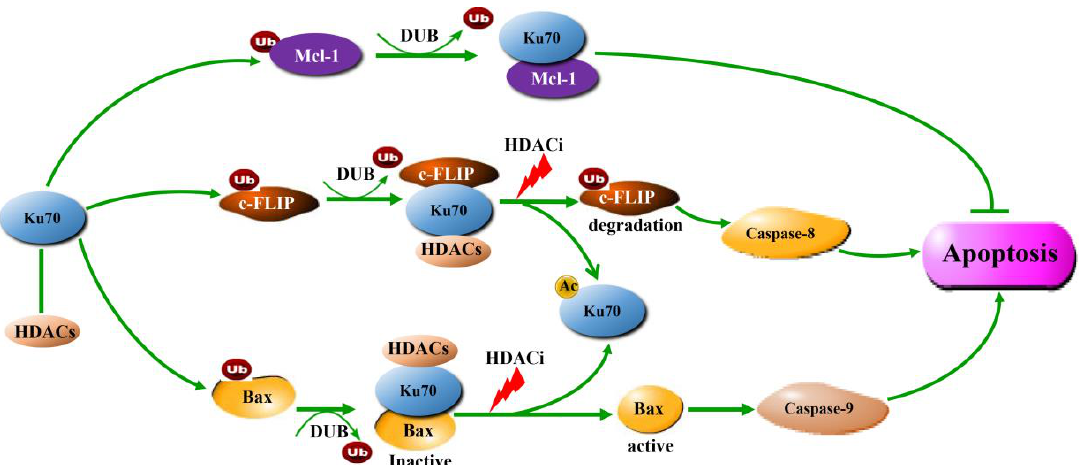
Figure 2. Cytoplasmic Ku70 regulates the activity and stability of apoptosis-related proteins via acetylation. Cytoplasmic Ku70 as a deubiquitinase binds to ubiquitinated Bax, c-FLIP, and Mcl-1 to prevent them from being degraded by proteasomes. After treatment with HDACi, Ku70 is acetylated and dissociates Bax and c-FLIP from the complexes, leading to Bax activation, c-FLIP degradation, and apoptosis initiation. It has been reported that inhibition of HDAC1, HDAC3, HDAC6, SIRT1, SIRT3, or SIRT6 induces Ku70-mediated Bax activation [62–67] and that inhibition of HDAC3 and HDAC6 induces Ku70-mediated c-FLIP degradation [62,125].